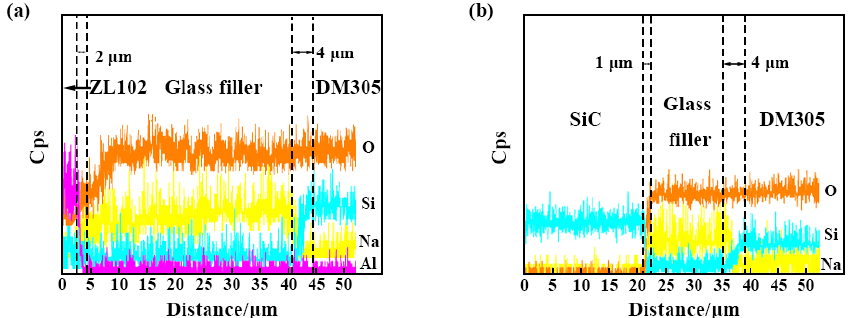
Figure 6. The line scanning results in Figure 5: ( a ) ZL102–Glass filler–DM305, ( b ) SiC–Glass filler–DM305.